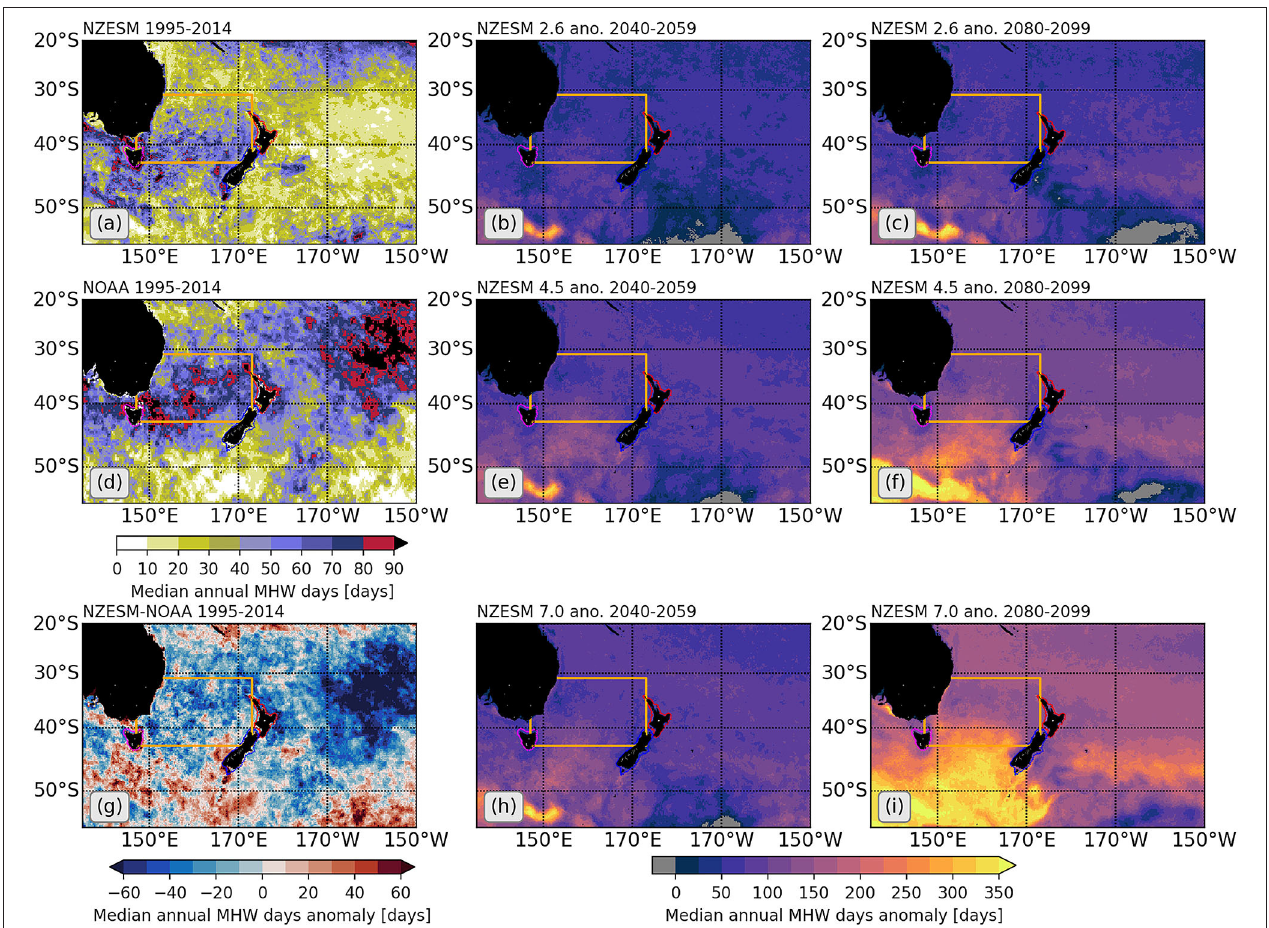
FIGURE 2 | Median annual MHW days for 1995–2014. (a) NZESM ensemble, (d) NOAA OI-SST and (g) the anomaly between NZESM ensemble and NOAA OI-SST. NZESM projected changes of median annual MHW days relative to 1995–2014: for SSP 2.6 in (b,c) for 2040–2059 and 2080–2099, respectively; for SSP 4.5 in (e,f) for 2040–2059 and 2080–2099, respectively; for SSP 7.0 in (h,i) for 2040–2059 and 2080–2099, respectively. Each panel of model data represents results of a 60 year member ensemble i.e., 20 years of data from each of the three ensemble members. The orange box indicates the Tasman Sea, while the coastal regions around North and South Island of New Zealand, and Tasmania, are illustrated by the red, blue and magenta dotted lines, respectively. A detailed map of the coastal regions and grid boxes which characterize these regions is provided in the Supplementary Figure S4